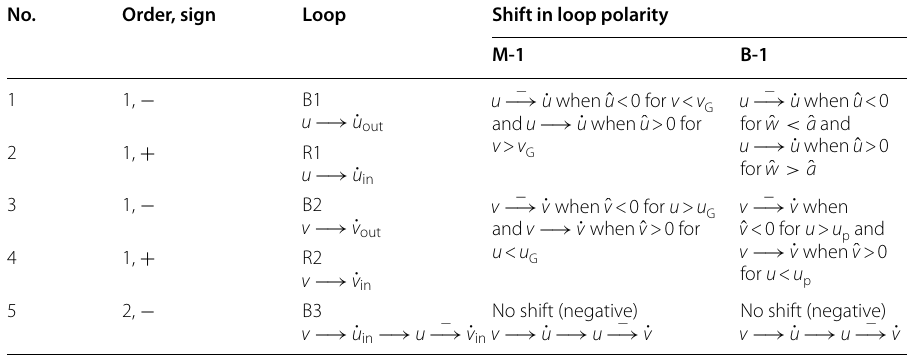
Table 2 Intensive feedback loops in M-1 and